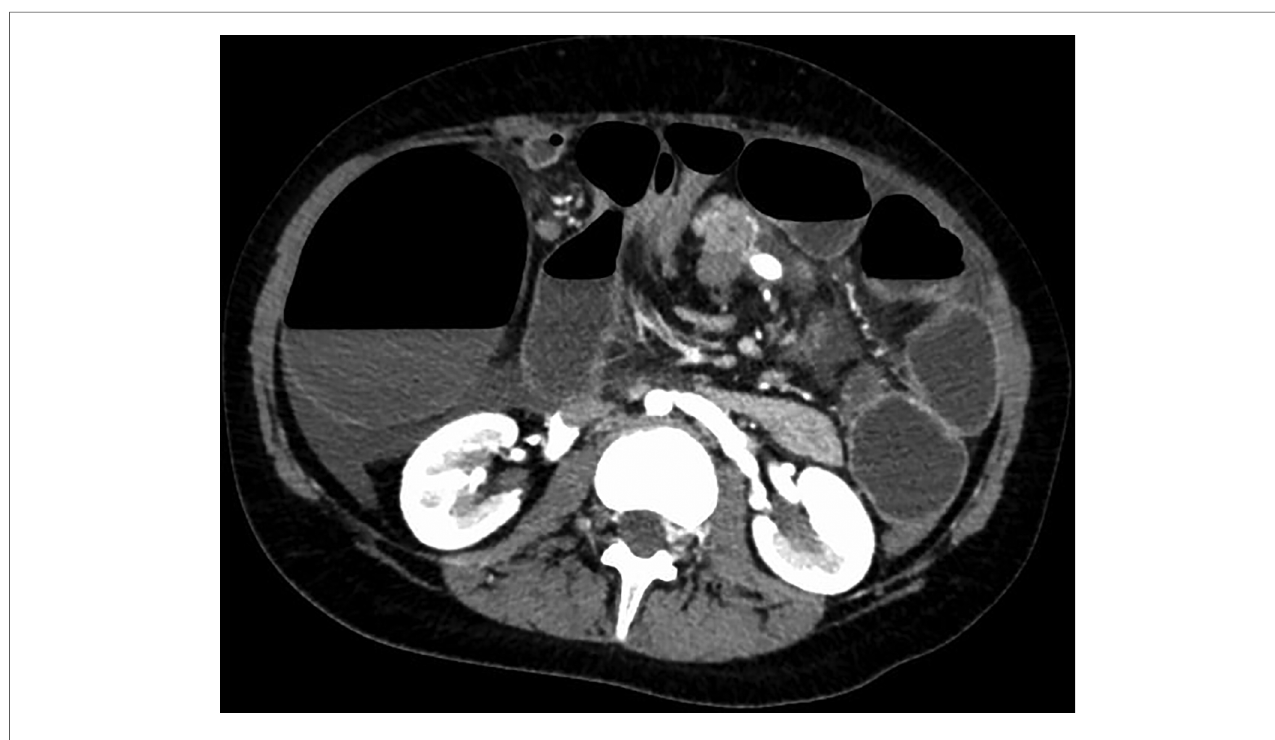
FIGURE 1 Transverse section of patient's CT scan upon admittance, showing whirpool sign of mesenteric vessels and dilated right colon with air- fl uid